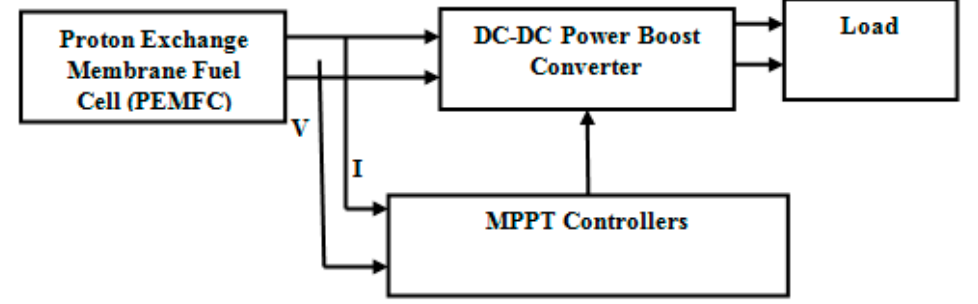
Figure 2. Proposed PEM–FC framework with different MPPT controllers.